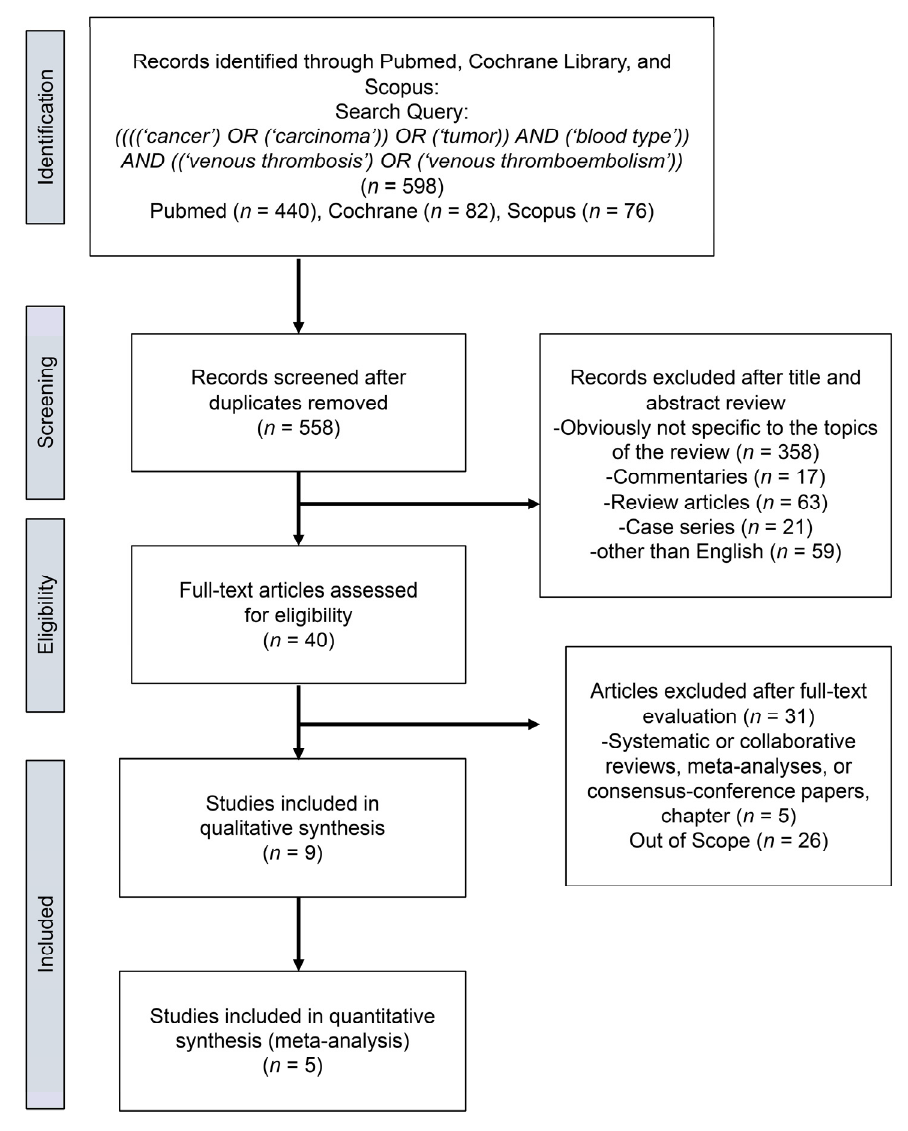
Figure 1. Preferred Reporting Items from the Systematic Review and Meta-Analysis (PRISMA) flow chart showing the process of article selection.